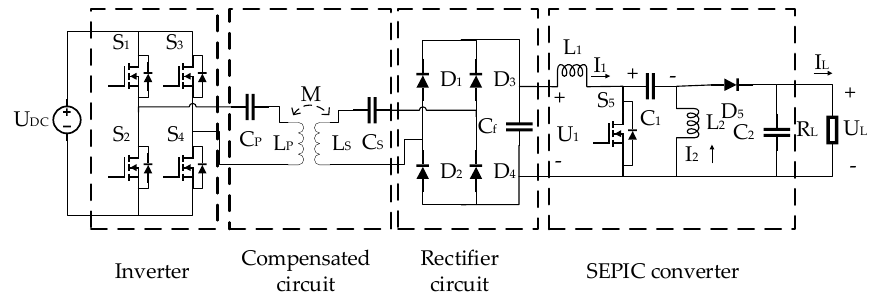
Figure 1. Proposed WPT system with bilateral independent control.